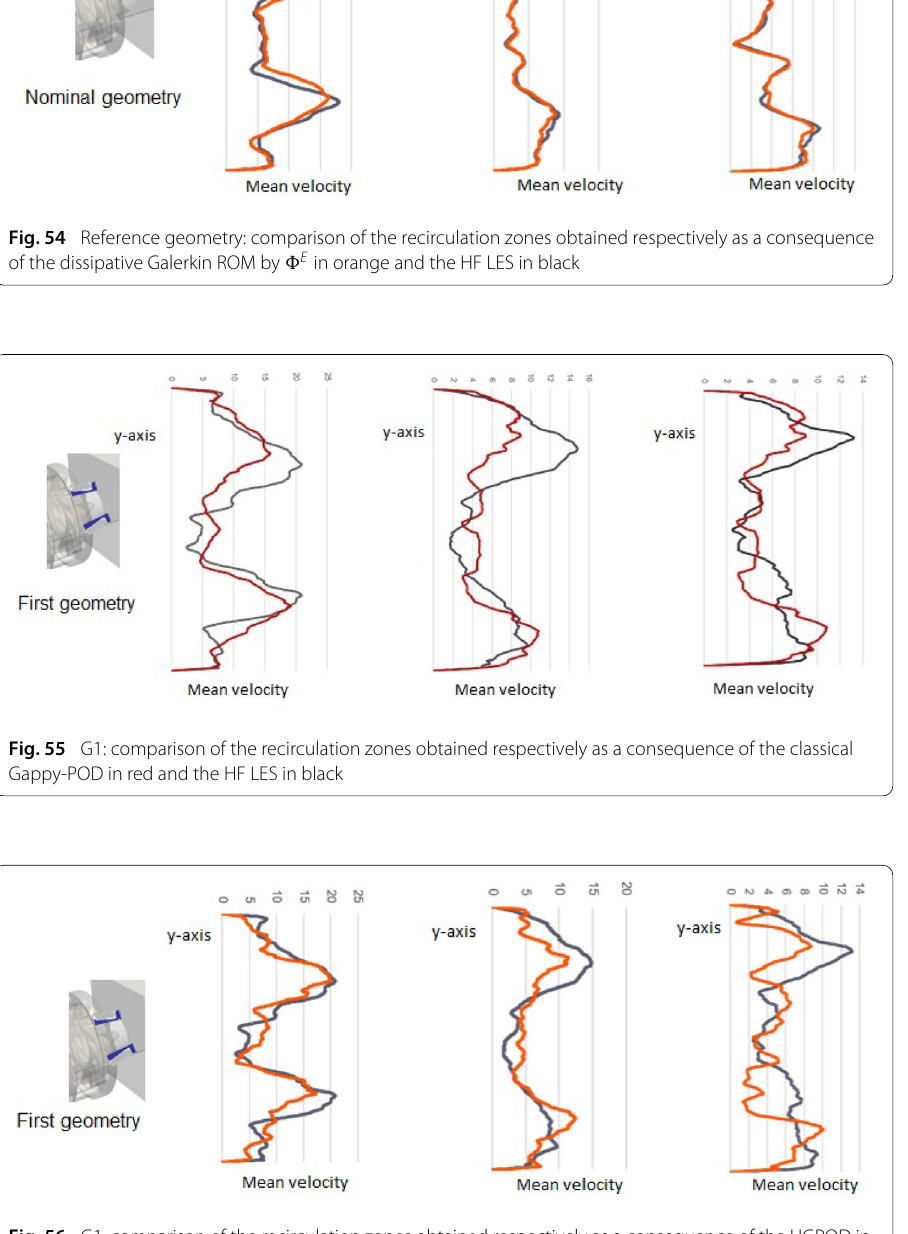
configuration, see Fig. 54. We see also that the classical Gappy-POD approach does not provide accurate results neither in the sense of the recirculation zones, nor in the sense of the 1D L 2 -relative errors all along the three y -axis respectively as shown in Table